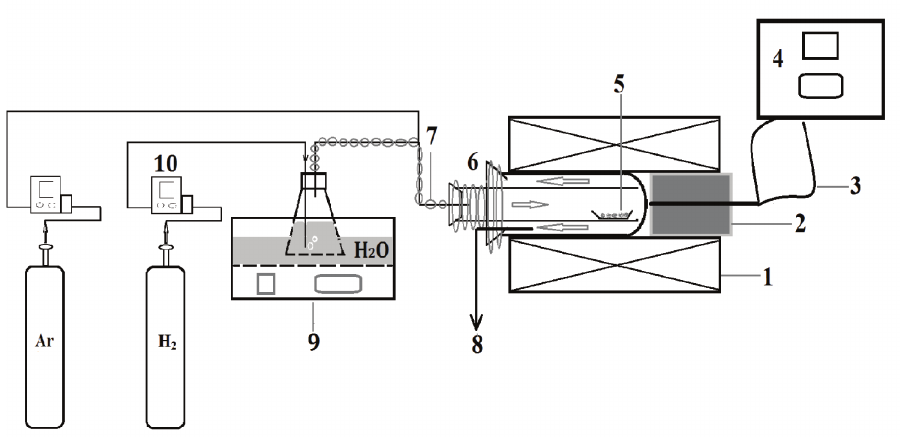
Fig. 2: Schematic diagram of the experimental apparatus. 1. Horizontal furnace, 2. Refractory brick, 3. Thermocouple, 4. Temperature controller, 5. Alumina boat with MoO 2 powder, 6. Quartz tube, 7. Heating wire, 8. Exhaust gases, 9. Water bath, 10. Gas flow